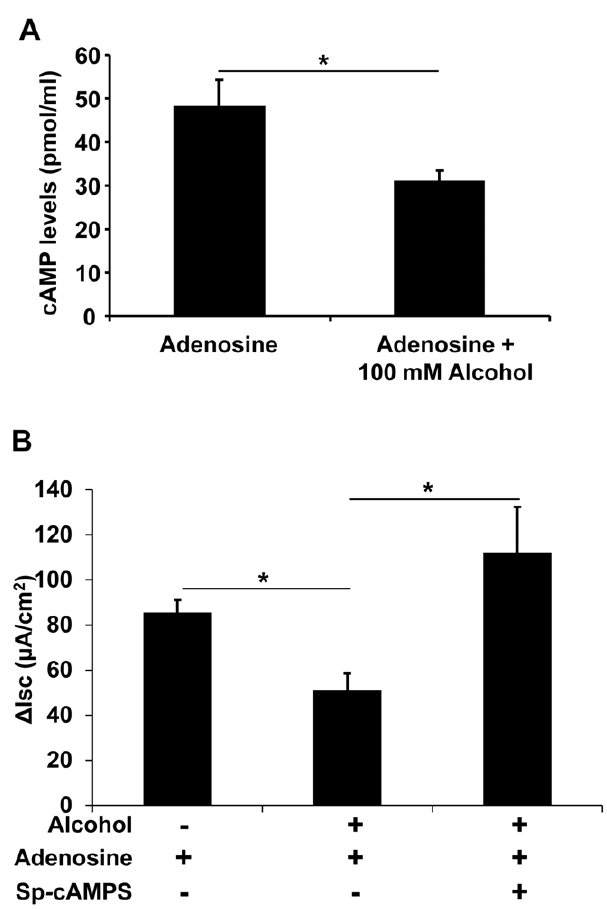
Figure 5. Effect of ethanol exposure on cellular cAMP level and adenosine analog antagonizes ethanol suppression of adeno- sine-induced chloride secretion. A ) Calu-3 epithelia, exposed to 0 and 100 mM of ethanol for 24 hours, were apically stimulated with 100 m M of adenosine for 10 min. Cells were lysed and cAMP levels were estimated by immunoassay. Ethanol pre-exposure significantly de- creased the adenosine-induced cellular cAMP level to , 64% of the no ethanol control ( p , 0.05, n=5). B ) In Calu-3 epithelia, ethanol pre- exposure decreased the adenosine-stimulated I SC . Such an inhibitory effect of ethanol on adenosine-induced I SC was antagonized by Sp- cAMPS, a phoshodiesterase-resistant cAMP analog ( p , 0.05,